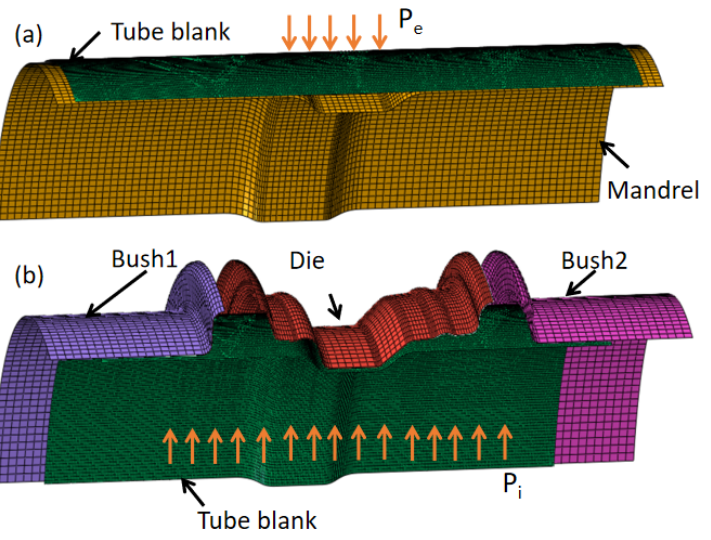
Figure 6. Process schematic of HIEP in the current study: ( a ) external pressure forming stage and ( b ) internal pressure forming stage. ( b ) internal pressure forming